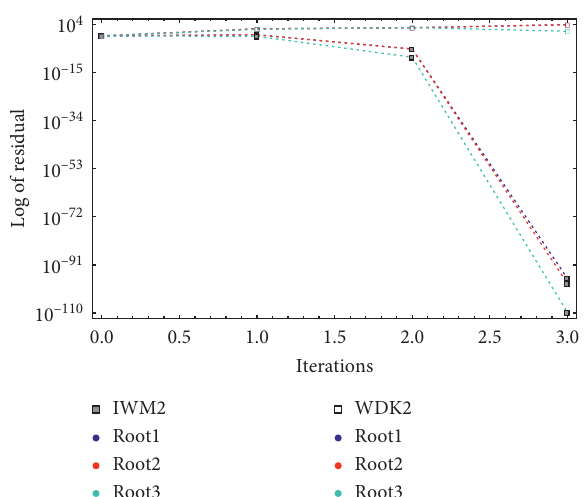
Figure 5: Error graph of WDK2 and IWM2 for f